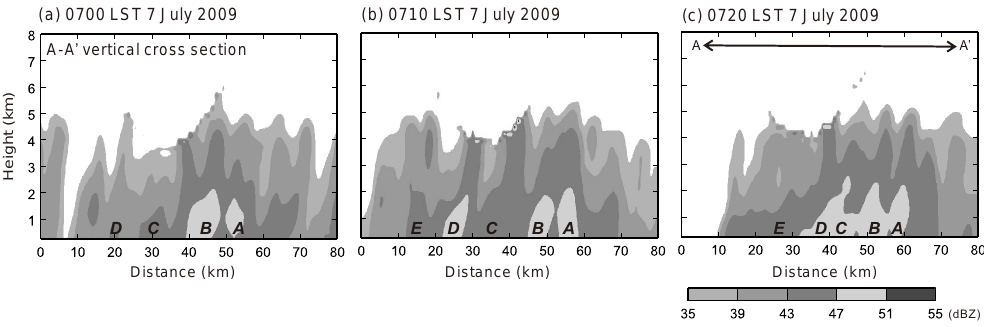
Figure 10. Vertical cross section of PSN radar reflectivity (dBZ, shading) along transect A–A (cid:48) shown in Fig. 9 at 10min intervals from (a) 07:00LST to (c) 07:20LST 7 July